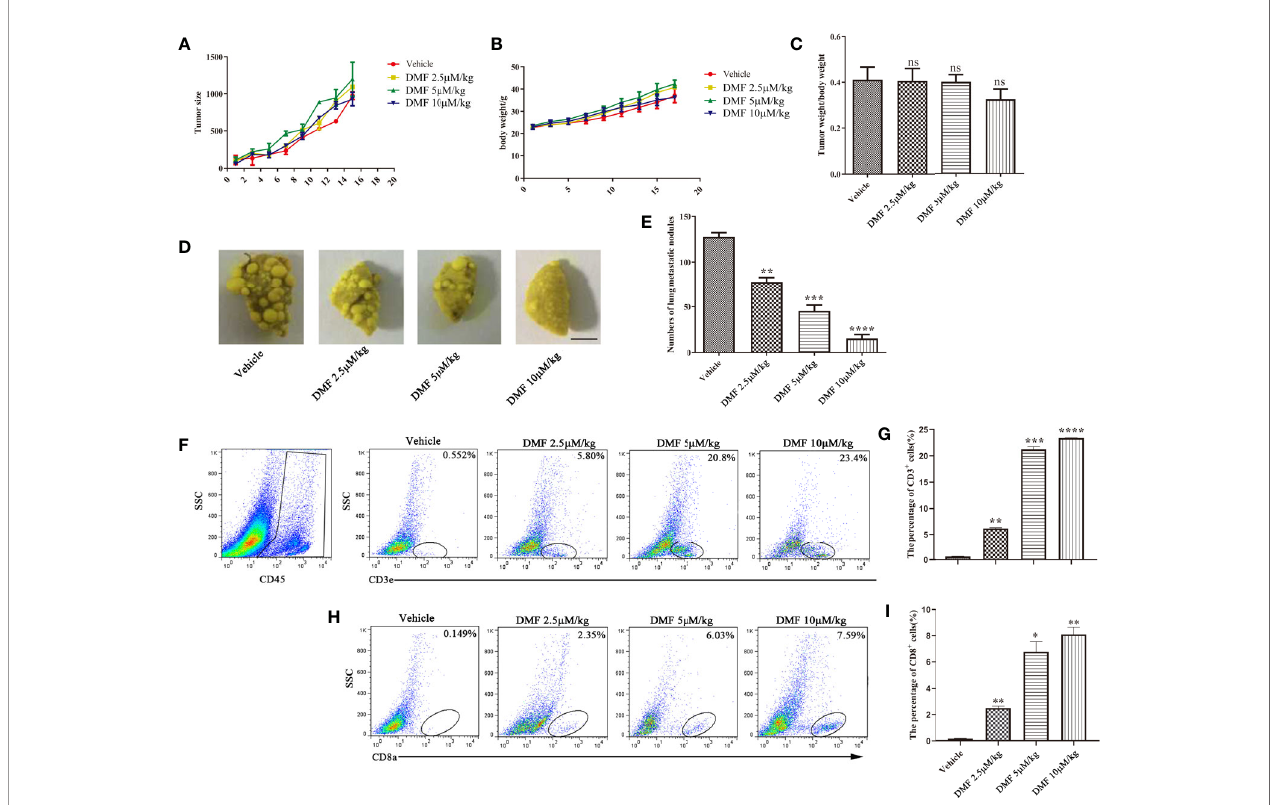
FIGURE 4 | DMF inhibits tumor metastasis in MMTV spontaneous breast cancer model. (A) Tumor growth of mice in each group was analyzed by measuring volume every 2 days (n = 5); (B) Weight of each group of mice is measure once every two days (n = 5). (C) The tumor weight of each group of mice was analyzed (n = 5). (D, E) , resection of lung tissue and counting of nodules to evaluate the anti-metastasis effect of oral DMF; Scale bar, 250 mm. (F, G) Flow cytometry analysis and quanti fi cation of CD3 + T cells in the tumor microenvironment of each group. (H, I) Flow cytometry analysis and quanti fi cation of CD8 + T cells in the tumor microenvironment of each group. Data are presented as the mean ± SEM. ns, no signi fi cance. * P < 0.05; ** P < 0.01; *** P < 0.001; **** P < 0.0001 as determined by the one-way ANOVA